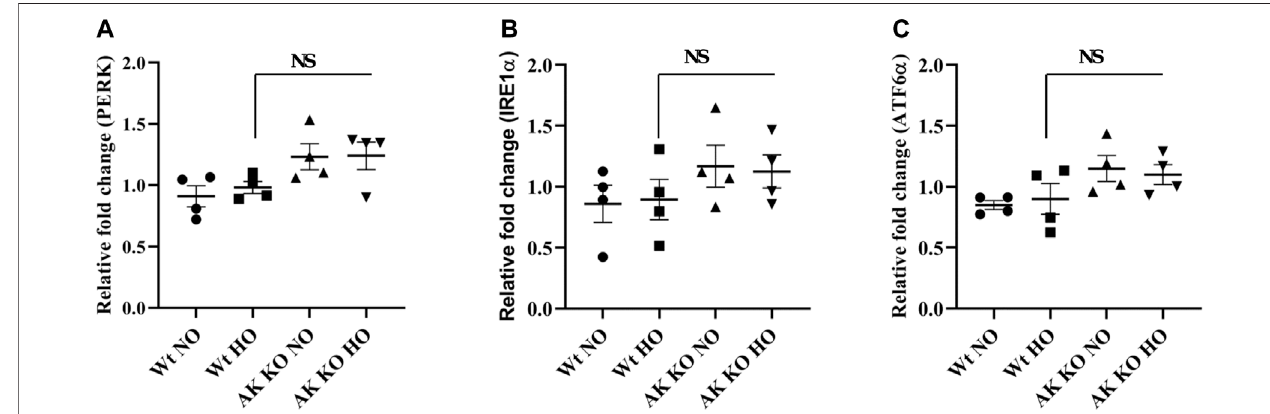
FIGURE1| Effectof Akap1 geneticdeletiononERstress-relatedreceptortranscripts: Wt and Akap1 micewereexposedtonormoxiaandhyperoxiafor48 h.After hyperoxia,themicewereeuthanized,andtotalRNAwasisolatedfromthelungsandsubjectedtoqRT-PCRanalysisandquanti fi edusingthe ΔΔ Ctmethod.Relativefold change in (A) PERK, (B) IRE1 α , and (C) ATF6 α is shown. Data are expressed as mean ± SEM ( n = 4 mice per group). NS, not signi fi cant; NO, normoxia; HO, hyperoxia; AK, Akap1 ; KO: